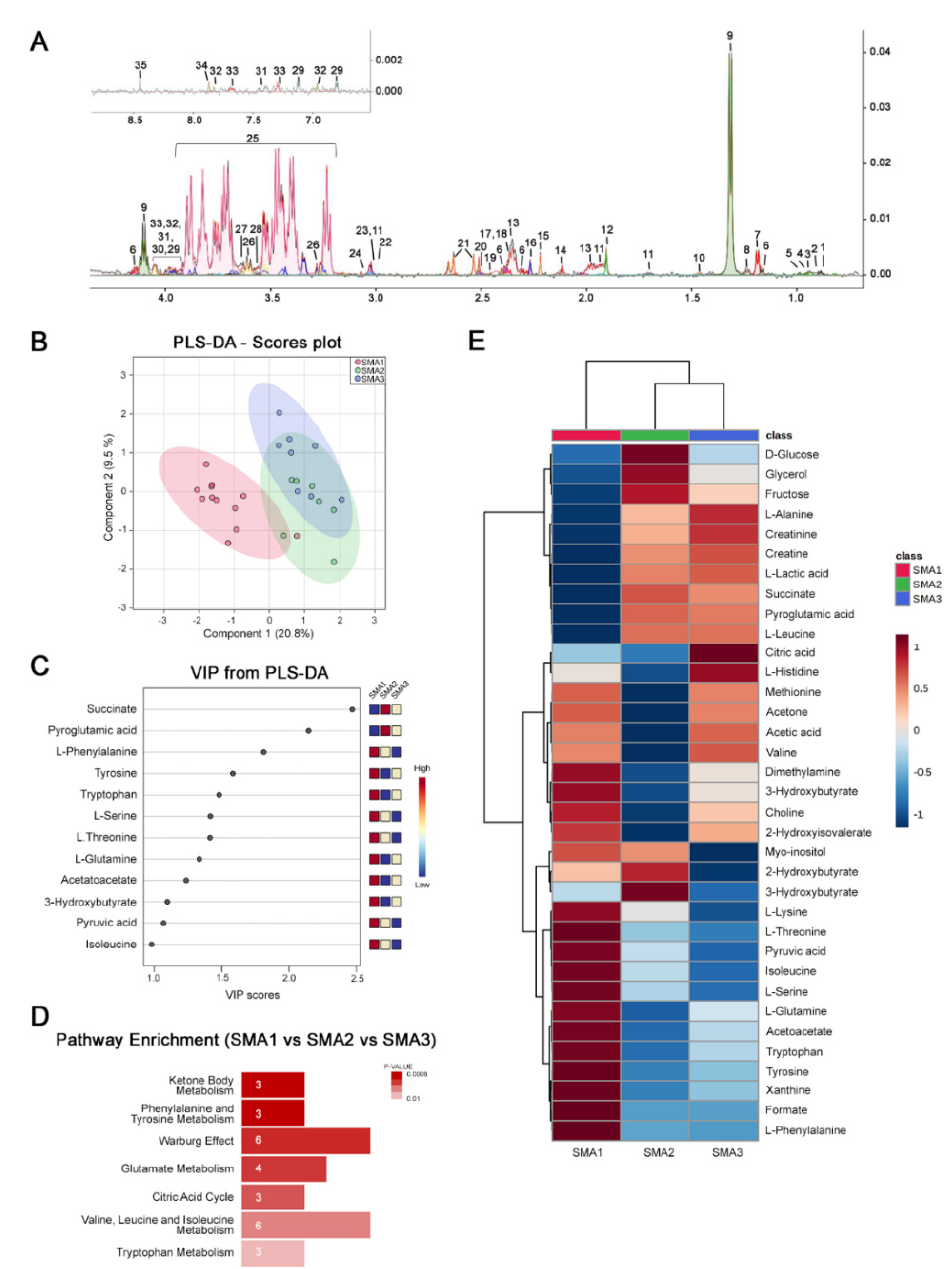
ware [42] on 1D 1 H CPMG NMR spectra obtained from the CSF polar extracts of SMA patients, detected the presence of 35 metabolites (Figure 1A). The quantification of assigned metabolites was carried out using automated Bayesil software [43].